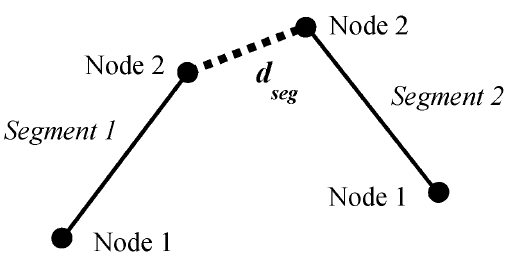
Figure 10. Tunneling path between a node and a segment.